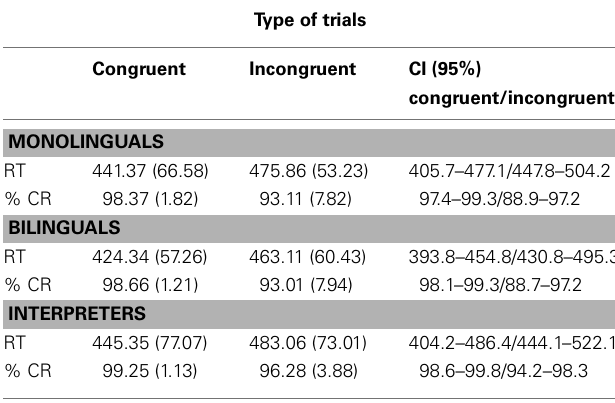
Table 4 | Mean reaction times (RT; in milliseconds) and percentage of correct responses (% CR and SD) for each group of participants for the Simon task. CI: 95% confidence